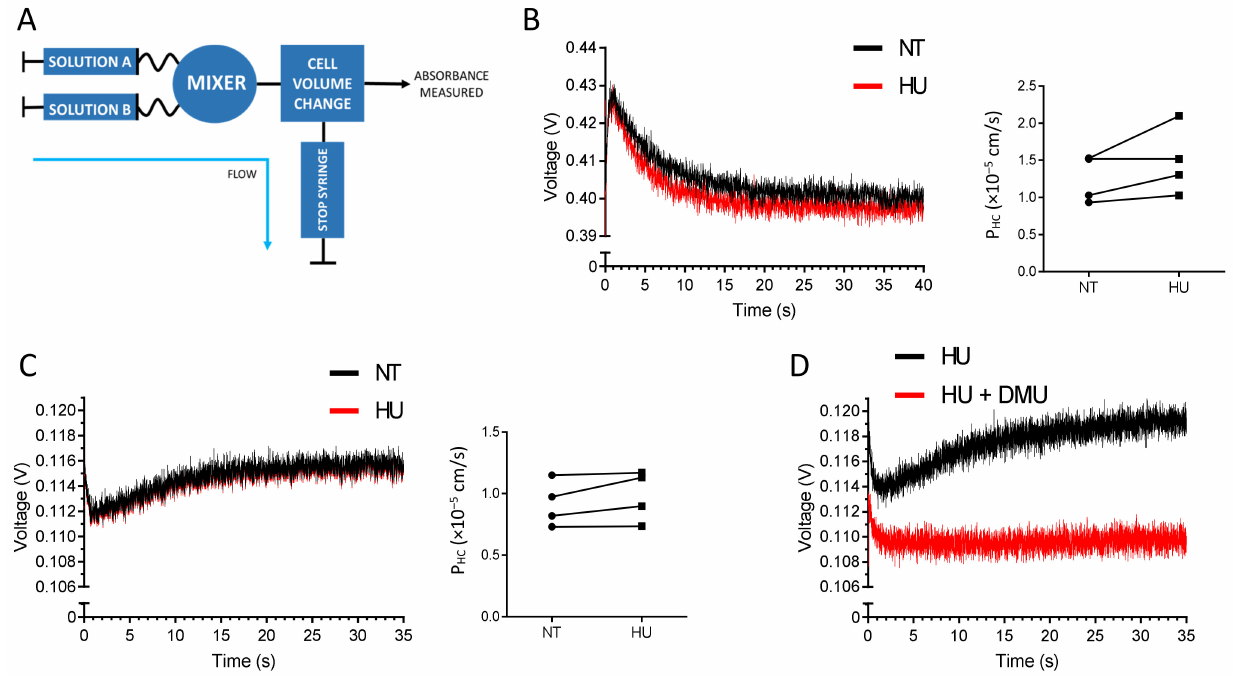
Figure 2. HU is not a substrate of ABCG2. ( A ) Schematic representation of the stopped-flow experimental setting. The RBC volume is measured in volts, and the cell volume dynamics is calculated as P HC (10 − 5 cm/s). ( B ) Representative HU import gradient (left panel) and HU entry kinetics (right panel) from four PV patients’ RBCs before HU treatment (black) and after HU treatment (red). Solution A: RBC suspension in PBS; Solution B: PBS + 100 mM HU. ( C ) Representative HU export gradient (left panel) and HU export kinetics (right panel) from four PV patients’ RBCs before HU treatment (black) and after HU treatment (red). Solution A: RBC suspension in PBS + 100 mM HU; Solution B: PBS. ( D ) HU transport gradient upon the blockage of UT-B by DMU. Solution A: RBCs in PBS + 100 mM HU with (red) or without (black) 15 mM DMU; solution B: PBS with (red) or without (black) 15 mM